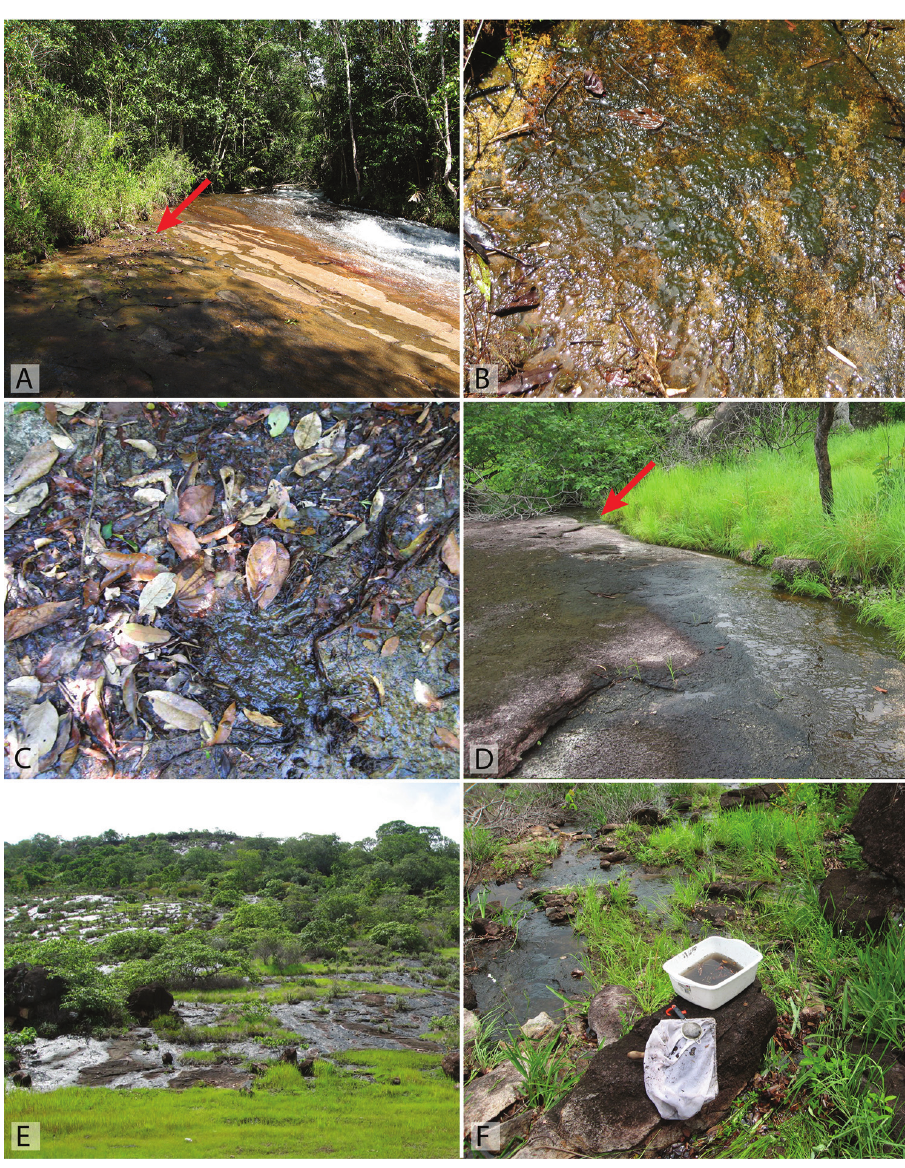
Figure 18. Habitat of Tobochares spp. in Venezuela. A–B Tobogan de la Selva, upstream, collecting event AS-08-080b, type locality for T. canaliculatus sp. n., T. sulcatus , T. canthus sp. n., and T. pallidus sp. n. C Tobogan de la Selva, collecting event VZ09-0114-01D D Outcrop near Pijiguaos, collecting event VZ10-0708-01B, habitat of T. pallidus sp. n. E–F Rock outcrop near Pijiguaos, collecting event VZ10-0709-01B, habitat of T. pallidus sp. n. Red arrows point to example microhabitats where speci- mens were